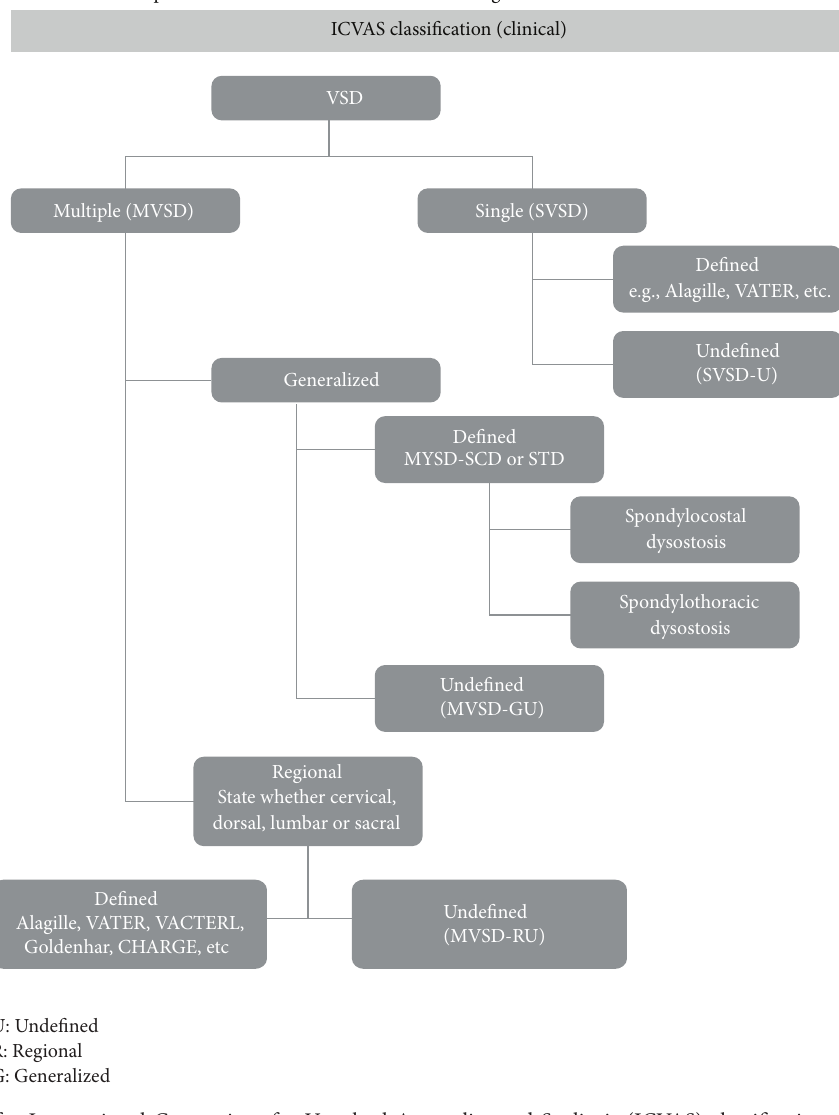
F 3: Algorithm for International Consortium for Vertebral Anomalies and Scoliosis (ICVAS) classi�cation of congenital vertebral malformation. Reproduced with permission Expert opinion in [7]. Reproduced from Expert Opinion in Expert Opin. Med. Diagn. (2008) 2(10):1107-1121 with permission of Informa UK